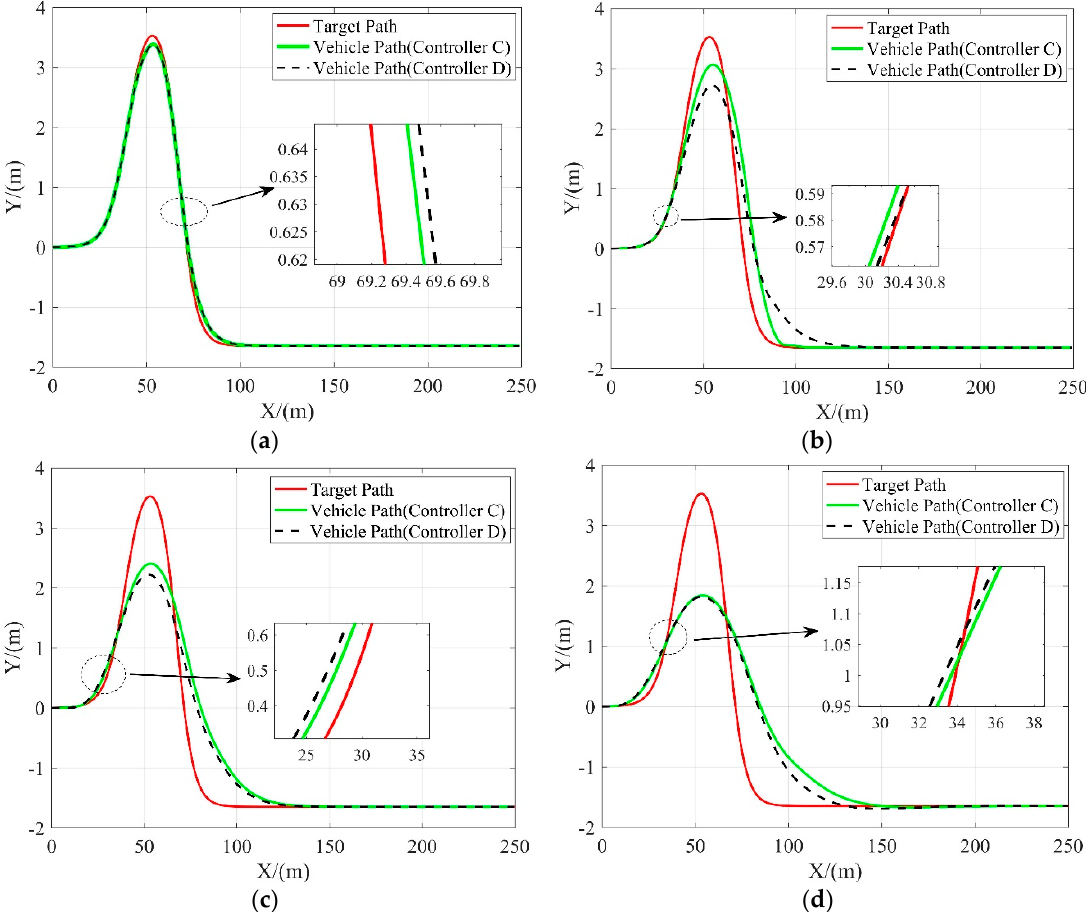
Figure 9. Tracking performance of 3 controllers in terms of the lateral position at different vehicle velocities. ( a ) 10 m/s; ( b ) 15 m/s; ( c) 20 m/s; ( d ) 25 m/s.